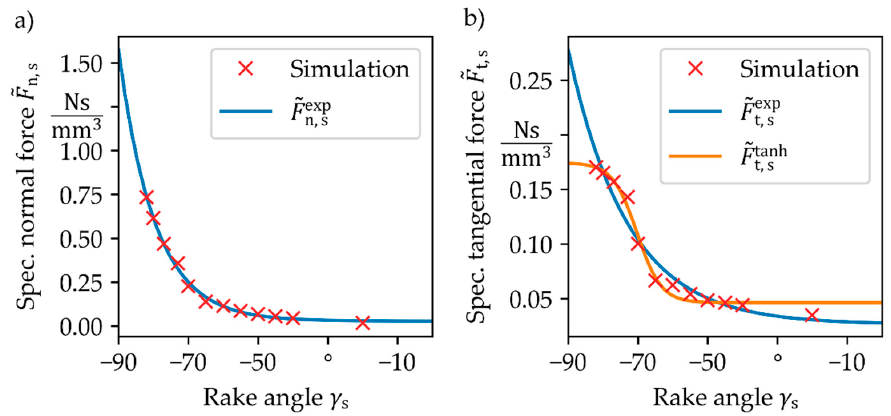
Figure 9. Specific single grain cutting forces obtained from the parameter study, and approximation by the proposed force models. ( a ) Normal forces, ( b ) Tangential forces. Table 4. Optimal force model coefficients based on results of the parameter